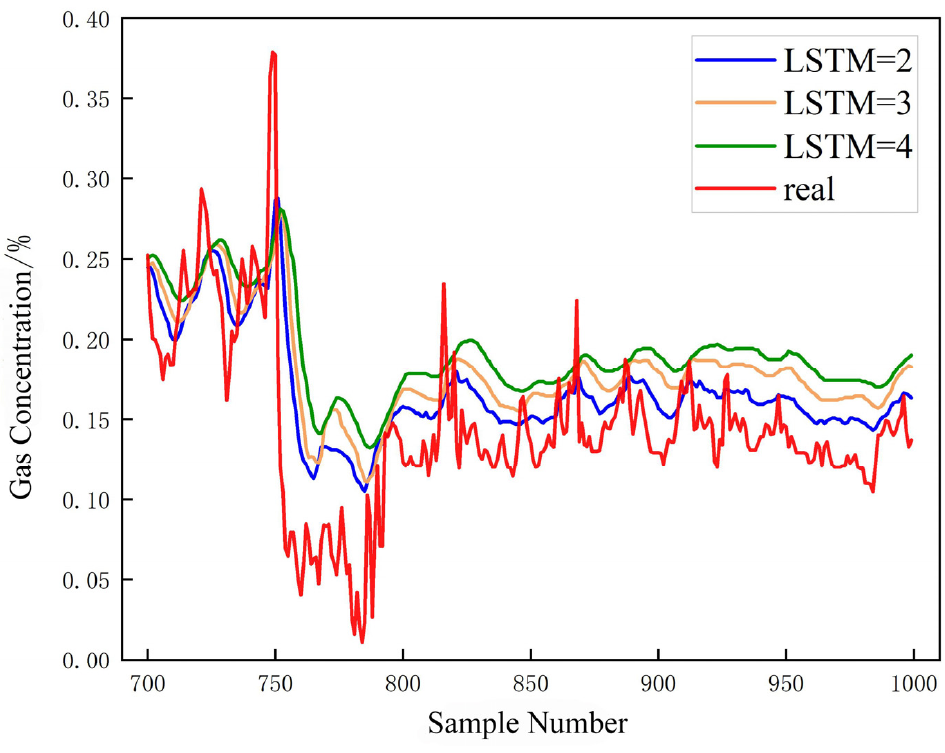
Figure 6. Comparison of LSTM layer losses.